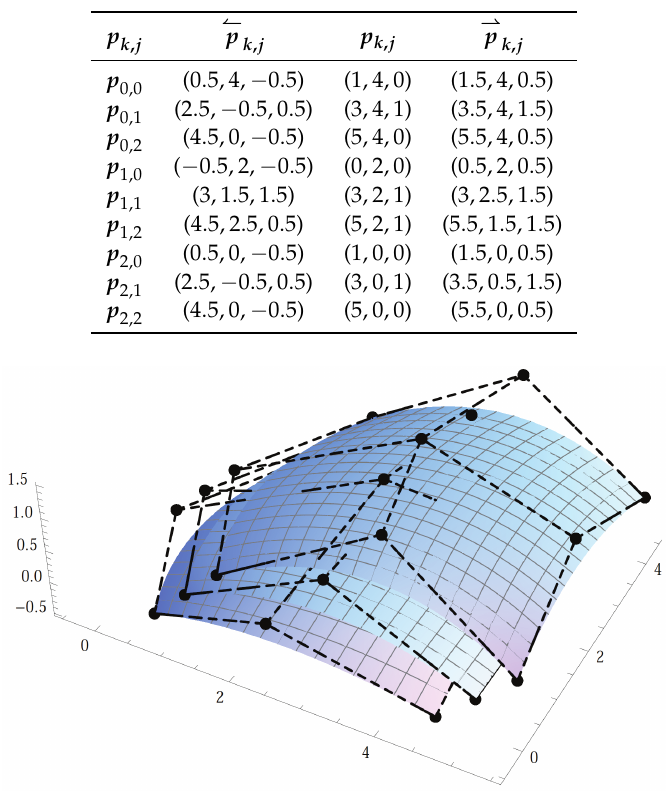
Table 1. Fuzzy control points.